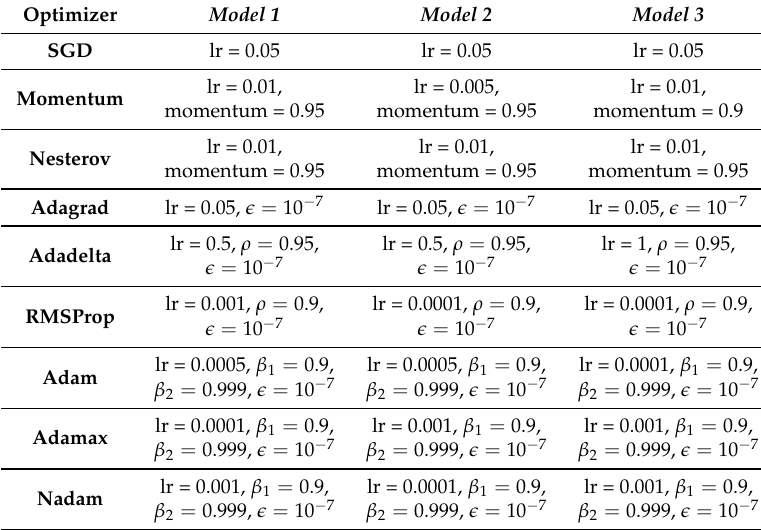
Table A3. Hyperparameters used on Fashion-MNIST